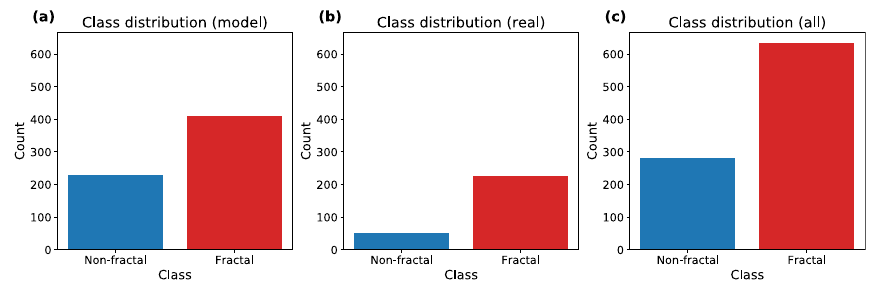
Fig. 12 Class distribution concerning fractality for a model generated, b real‑world, c all of the examined networks